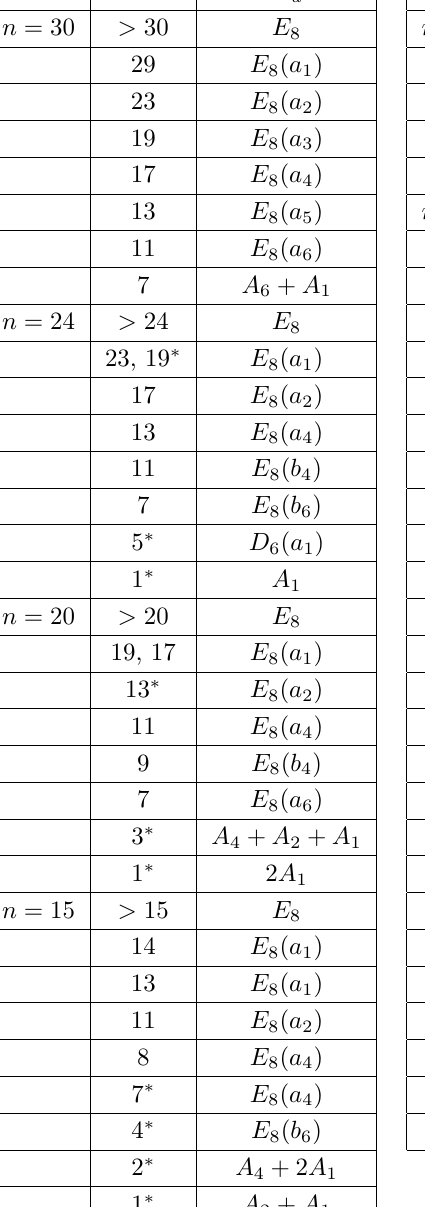
u − 4 . n is the number. For v = 0 ); To pick D ( a ) , we use the following v 6 1